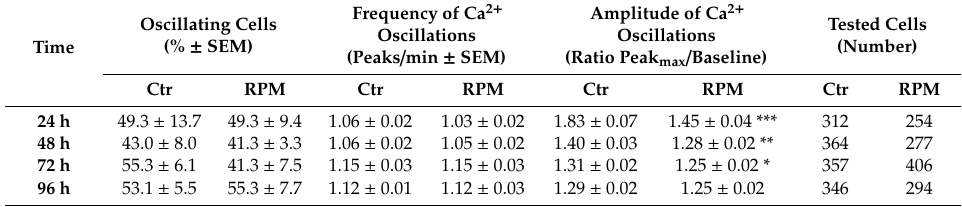
Table 1. Quantitative analyses of the spontaneous intracellular Ca 2 + variations.